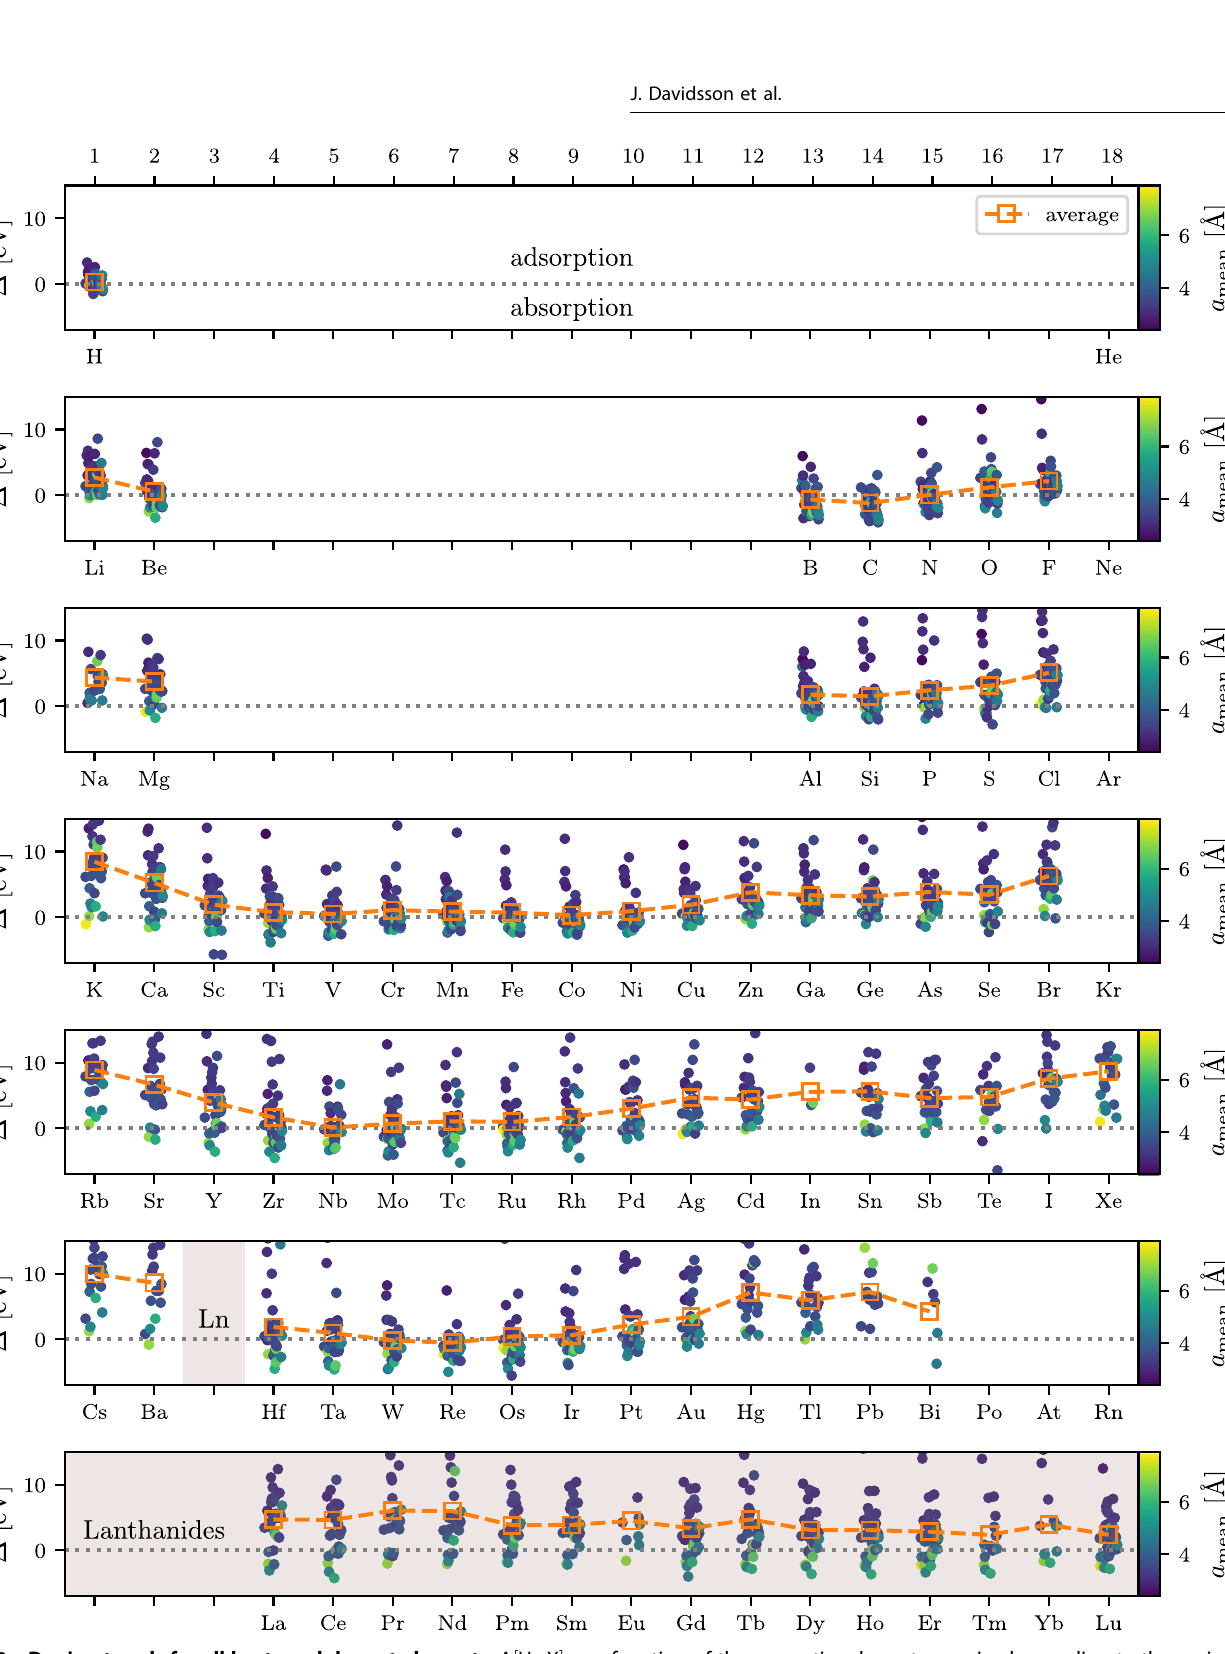
Fig. 3 Doping trends for all hosts and dopant elements. Δ H ; X ½ (cid:2) as a function of the respective dopant organized according to the periodic table order of the impurity species. Negative values correspond to stable interstitial. The different dots in one particular column represent the different host crystals. The average lateral size of the primitive host crystal unit cell is given by the color code of the data points. The orange squares visualize the average Δ -value over all host crystals for a given